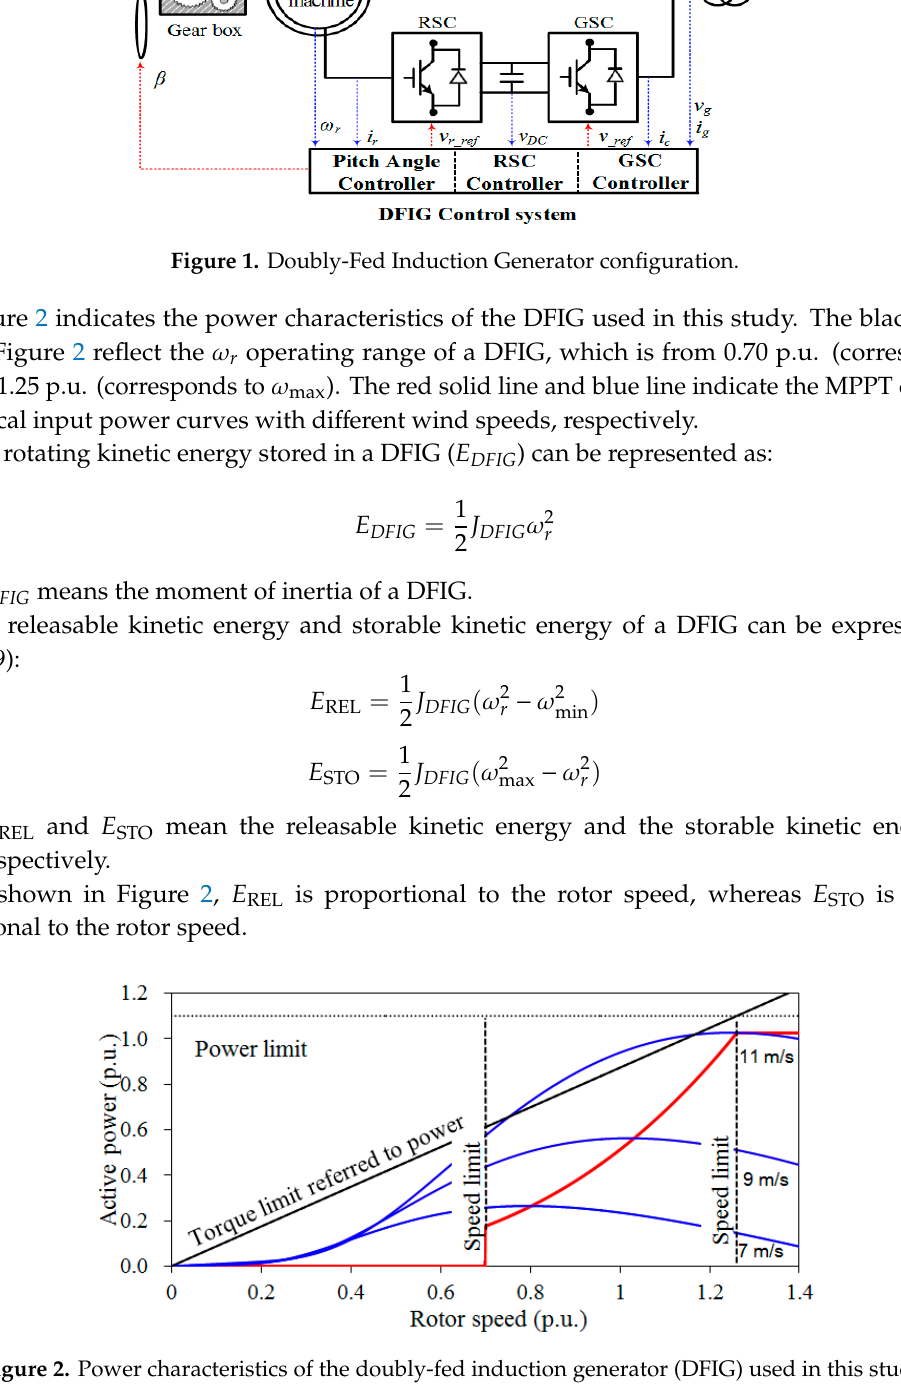
Figure 2. Power characteristics of the doubly-fed induction generator (DFIG) used in this